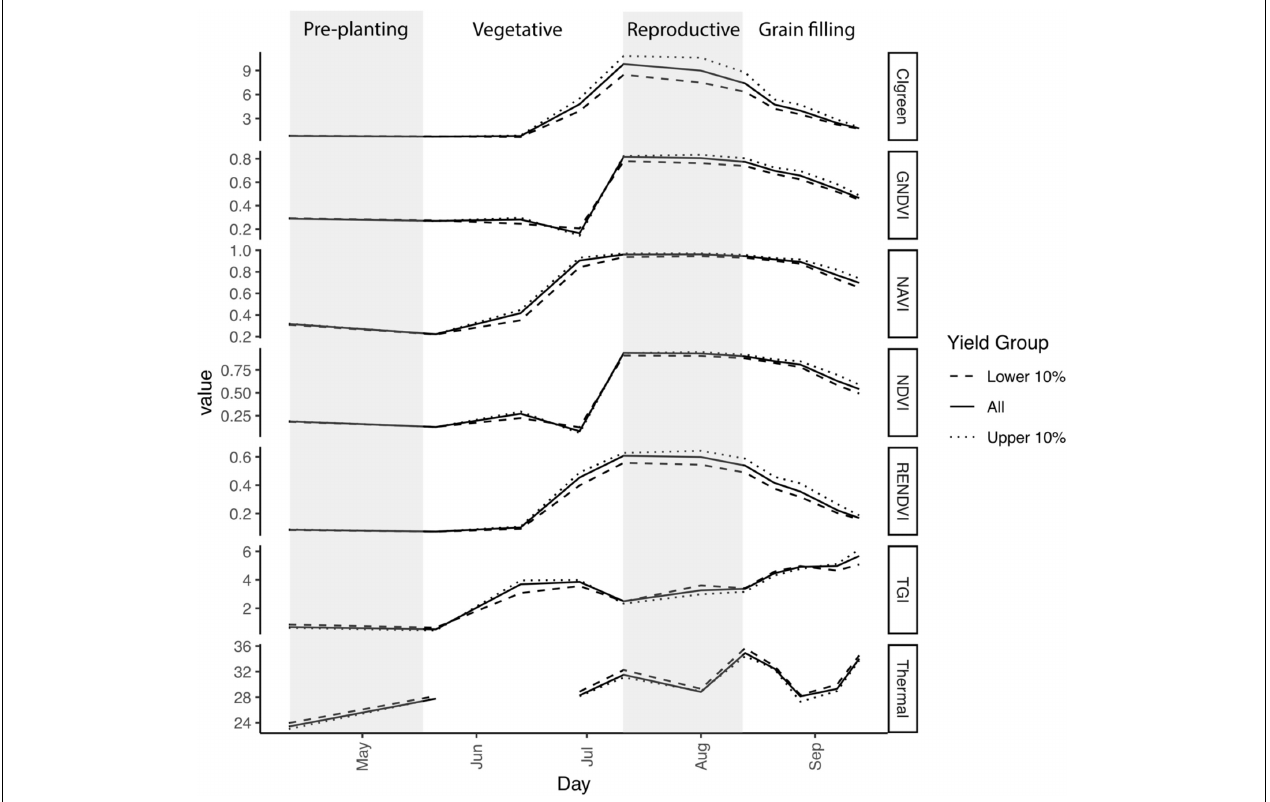
FIGURE 2 | Variation in temperature and six vegetation indices over time in 2019. Gray shaded areas indicate time prior to seeding and the reproductive phase (panicle initiation through flowering anthesis). Additional details regarding growth stages for each flyover date are provided in Table 2 . First flooding occurred on 29 June, resulting in a dip in NDVI and GNDVI. Plotted values are the mean for 50 cm × 50 cm pixels with yield in the lower 10% ( n = 52,649), the upper 10% ( n = 52,537), or all pixels ( n = 526,735). Thermal was not available for the flyover on 13